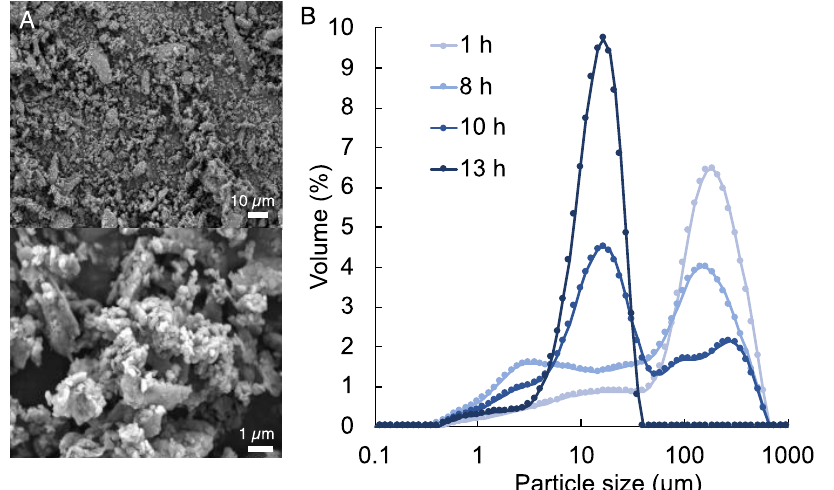
Figure 2. ( A ) SEM images of the bone particles that are pulverized for 13 h. ( B ) Plot showing the particle size distribution for pulverized (1–13 h) bone particles. The change in ink viscosity with shear rate for neat and composite inks are given in Figure 3A. The shear viscosity of the MeALG bioink significantly increased with the ad- dition of bone particles, such that viscosity values at low shear rates (0.01 s − 1 ), approaching to zero shear viscosity, increased from ~7 to ~30 Pa·s. Both ink formulations show shear thinning behavior indicated by the significant decrease in shear viscosity with increasing shear rate. Shear thinning behavior of the MeALG is known to be associated with chain entanglement [97], which resists ink flow at low shear rates. The degree of shear thinning